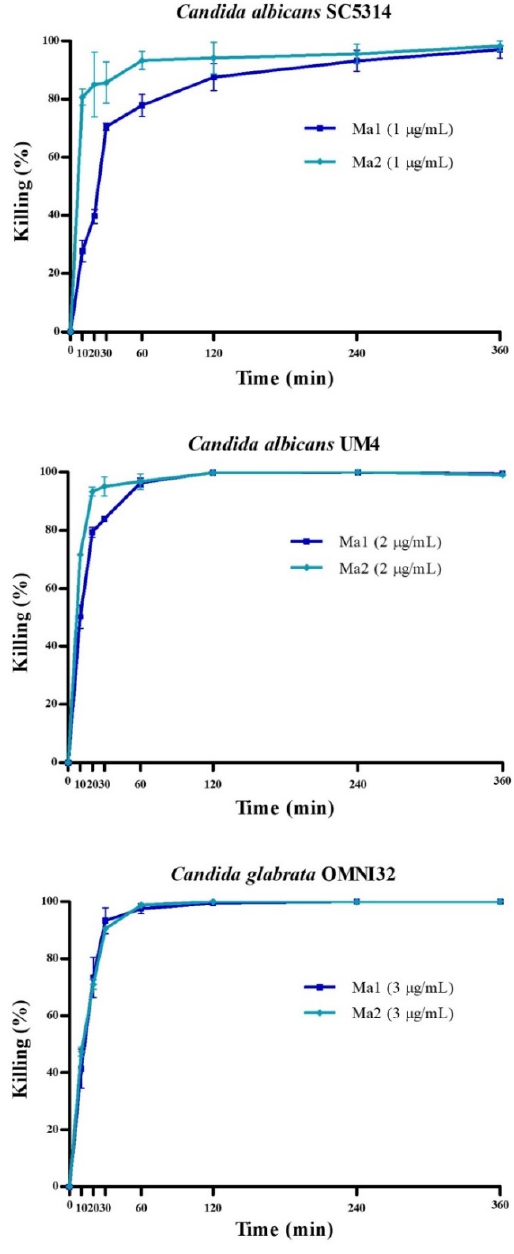
Figure 2. Time kinetics of in vitro activity of Ma1 and Ma2 against Candida albicans SC5314, C. albicans UM4, and C. glabrata OMNI32. The minimal fungicidal concentrations were used for both peptides. Reported data represent mean values ± standard deviation.